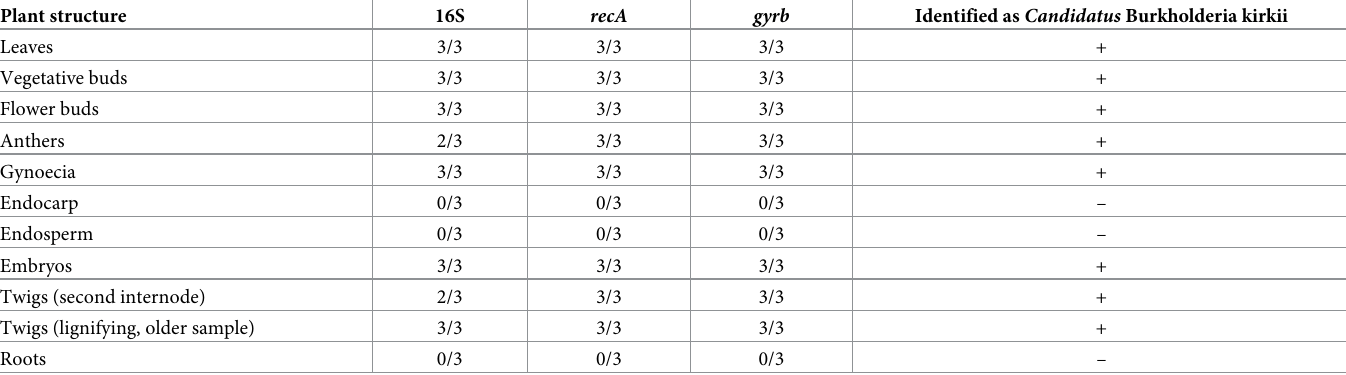
Table 1. Results of the PCRs with the specific primers for the genus Burkholderia . Of each plant structure, three biological replicates were tested. If the sequences were identified as Candidatus Burkholderia kirkii, the presence of the host specific endophyte is indicated with a +, otherwise the absence is indicated with a–in the last column. Plant